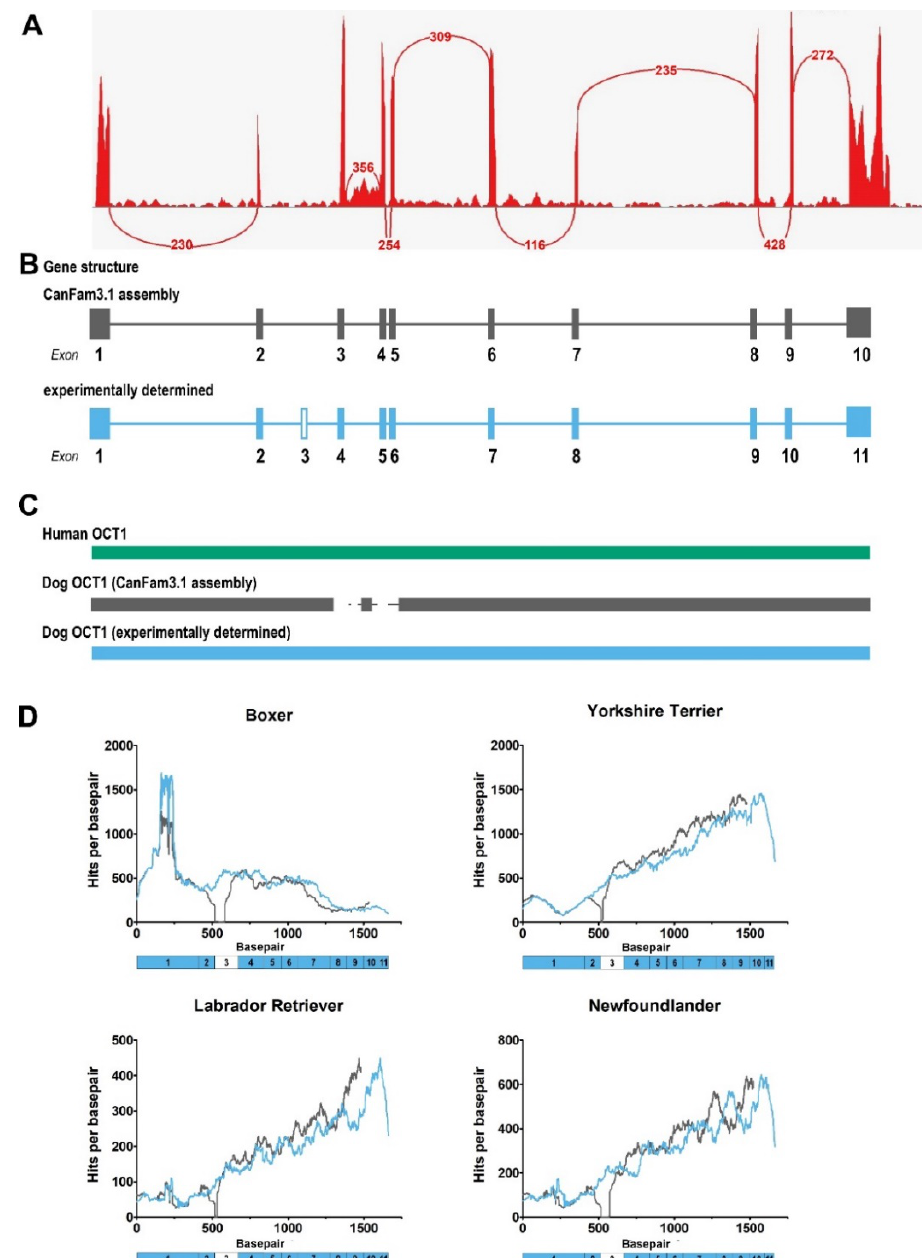
Figure 1. Gene structure of dog OCT1. ( A ) Sashimi plot showing OCT1 (SLC22A1) RNA-Seq reads from Beagle dog liver mapped onto chromosome 1 of the CanFam3.1 dog genome assembly. Exon junctions based on spliced reads are connected by lines, with the number indicating the number of splice junctions mapped. RNA-Seq dataset PRJEB33381 from ENA at EMBL-EBI was used. ( B ) Exon- intron structure of dog OCT1 according to the CanFam3.1 genome assembly (top) and our